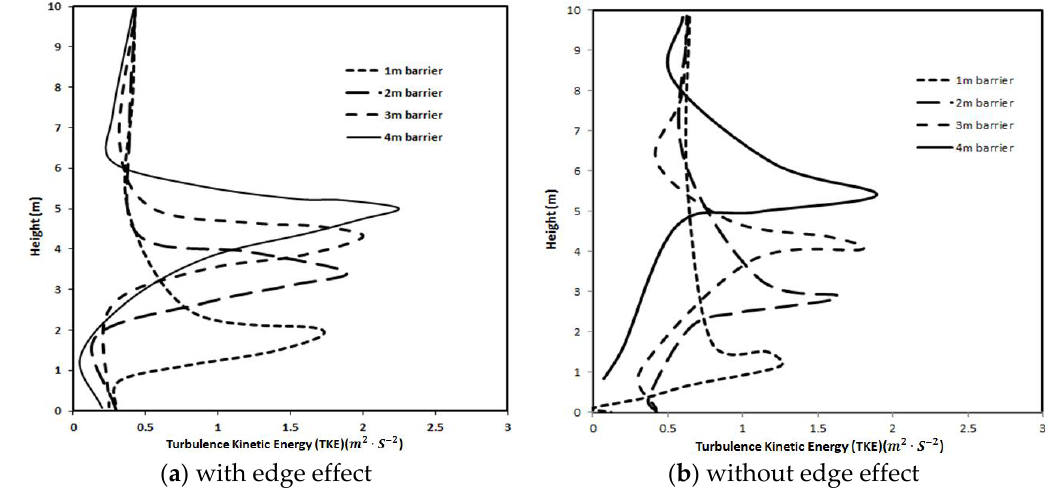
Figure 10. Turbulence kinetic energy vertical profile in the symmetry plane. Table 2. Comparison of the peak turbulence kinetic energy (TKE) in the symmetry plane for with and without edge effect cases.